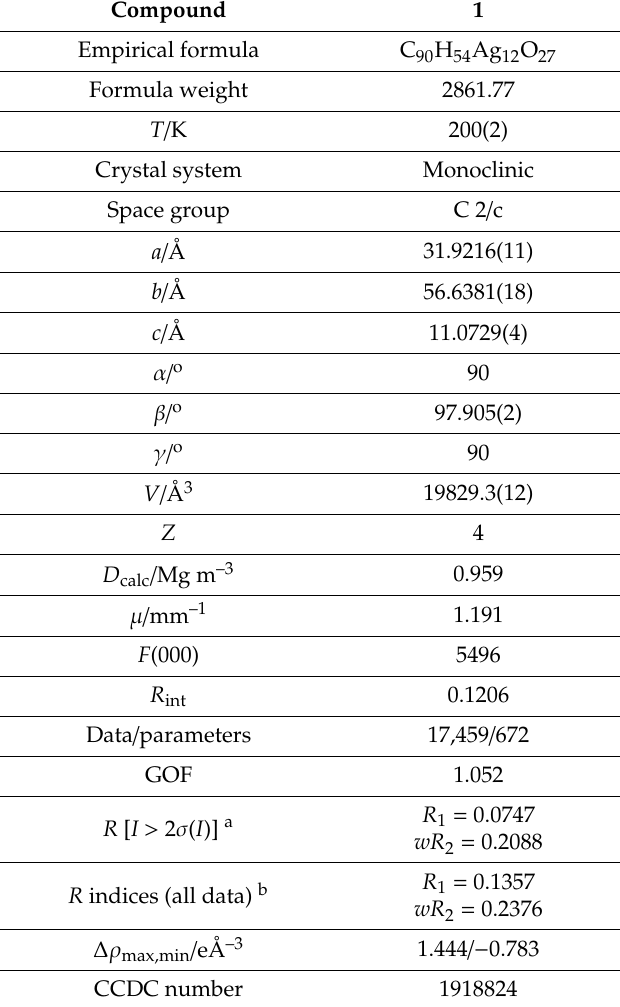
Table 1. Crystal data and structure